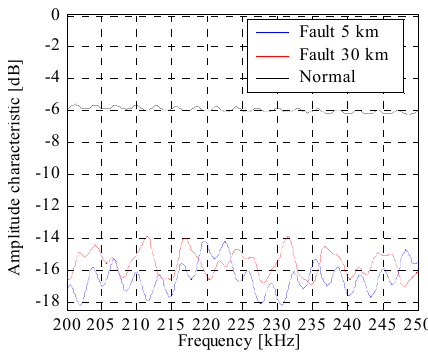
Figure 12. Amplitude characteristics of the faulted power line for fault distance 5 and 30 km from the sending terminal. The middle phase to ground coupling. The broken middle phase conductor short-circuited at the left side and open-circuited at the right side at the fault location.